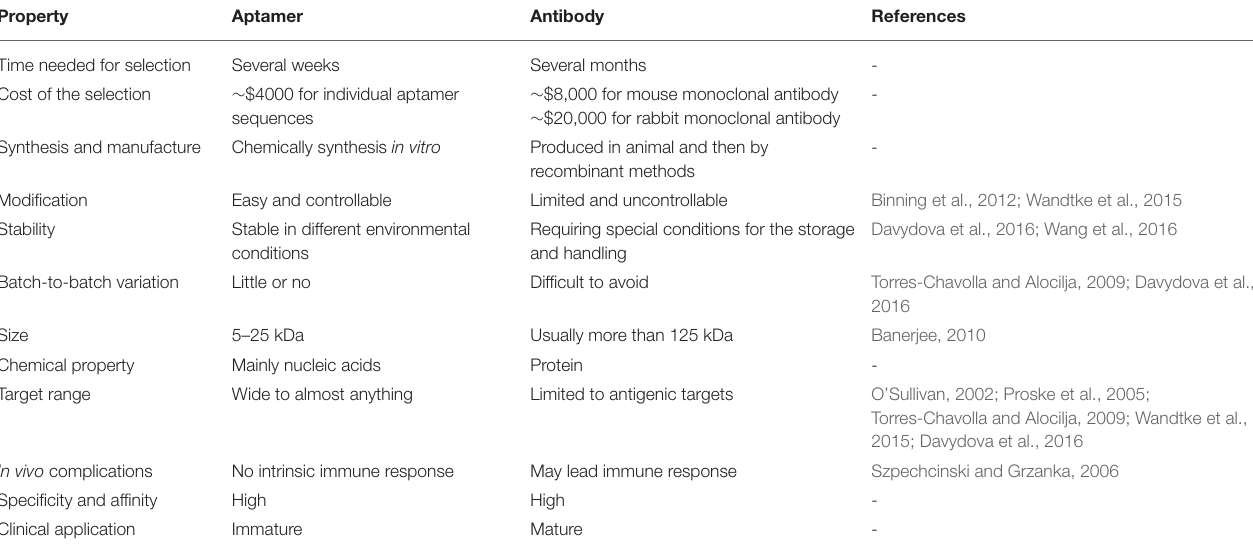
TABLE 1 | Comparative properties of aptamers and